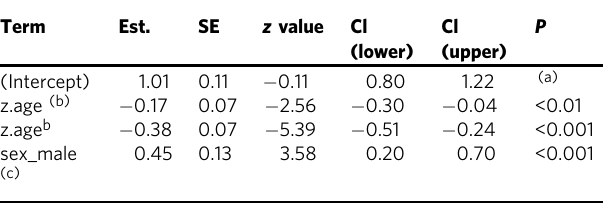
Table 2 In fl uence of age, sex and rank on the production of af fi liative signals (model 2).